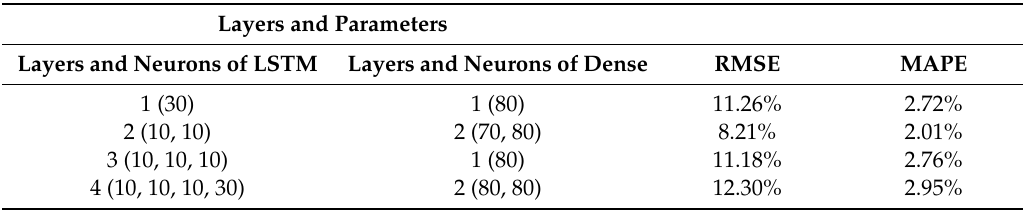
Table 2. Comparison of di ff erent model structures for summer in RMSE (root mean square error) and MAPE (mean absolute percentage